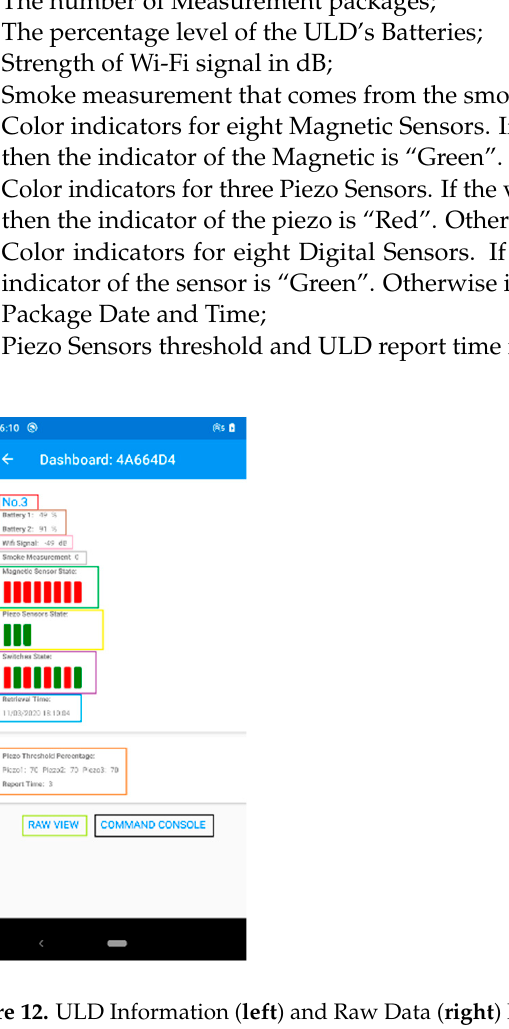
Figure 12, on the left in the color frames: